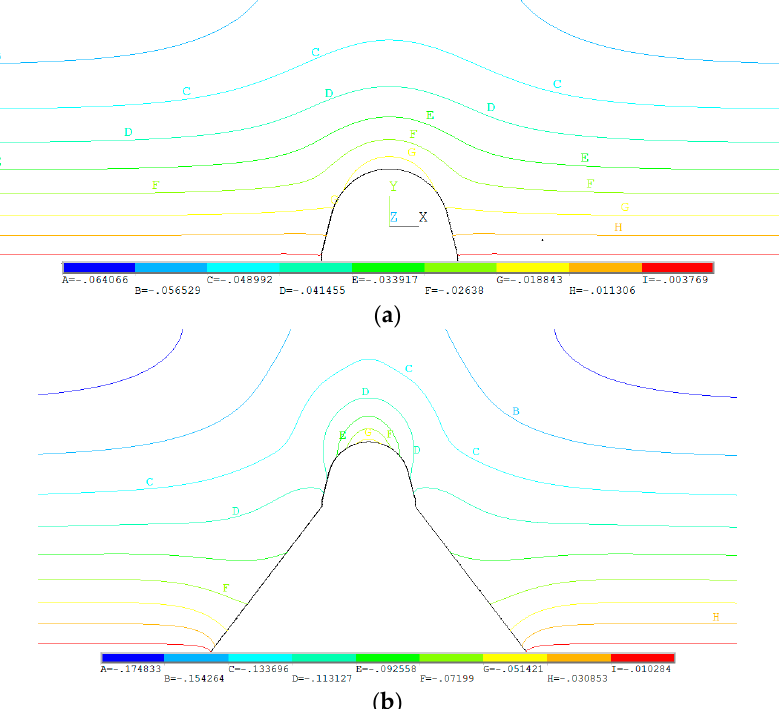
Figure 20. Settlement difference between the inside and outside soil columns. ( a ) Settlement difference for sample A1; ( b ) Settlement difference for sample A2.